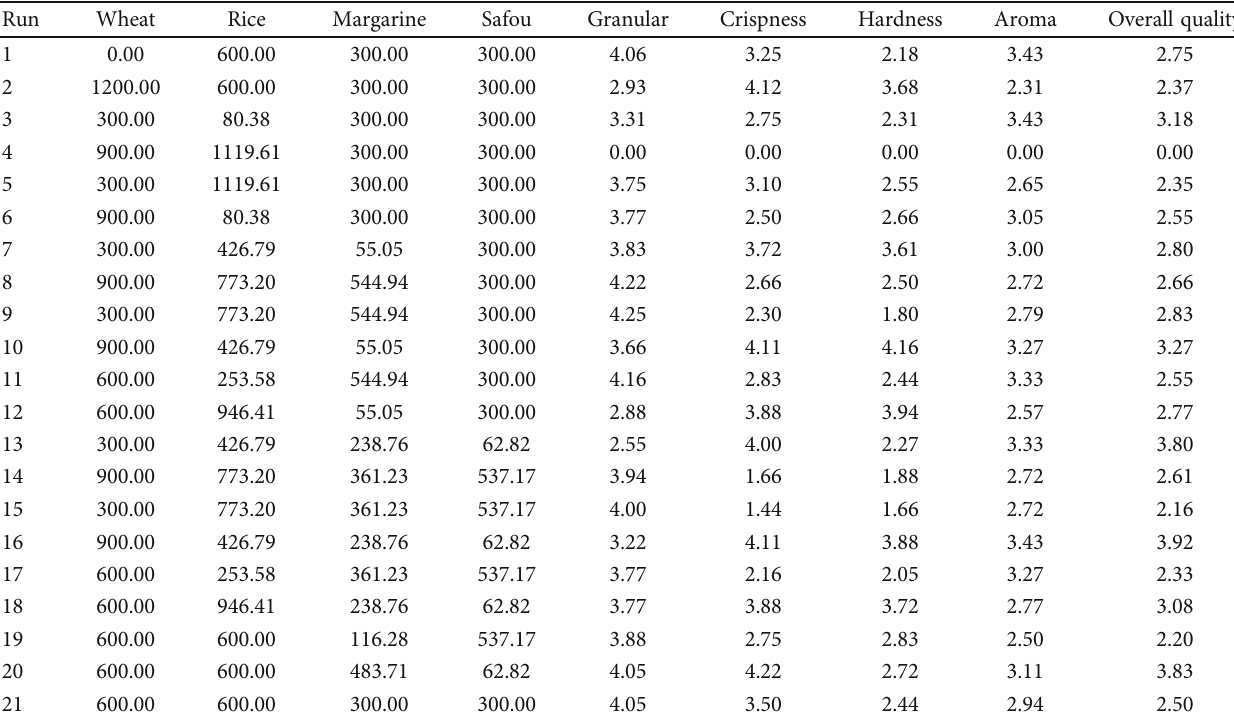
Table 2: Design of the experiment and responses of the Doehlert design for the production of rice biscuits supplemented with safou powder. Run Wheat Rice Margarine Safou Granular Crispness Hardness Aroma Overall quality